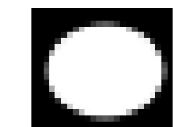
Figure 17. Synthetic target based on sampling the rectangular